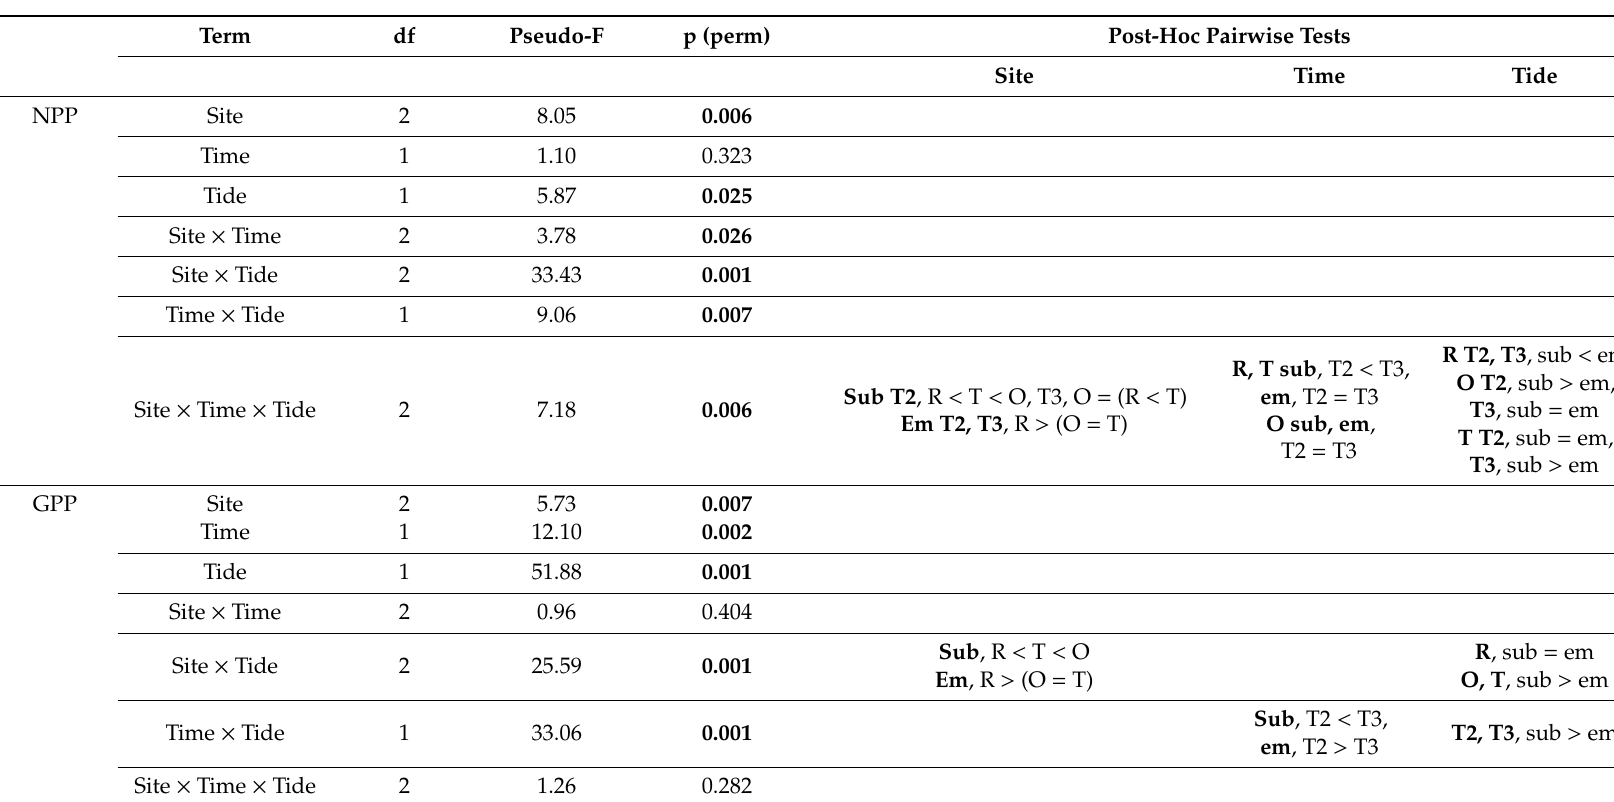
Table 5. Results of repeated measures PERMANOVAs testing the e ff ect of site and tidal state at two di ff erent sampling dates on measures of primary production. Site (3 levels: RAG, TAU-O and TAU-T), time (2 levels: T2 and T3) and tide (2 levels; submerged and emerged) were treated as fixed factors and replicate plot nested within site. Site names have been further abbreviated as: R = RAG, O = TAU-O and T = TAU-T and submerged and emerged tidal periods to sub and em, respectively. Significant e ff ects ( p < 0.05) are given in